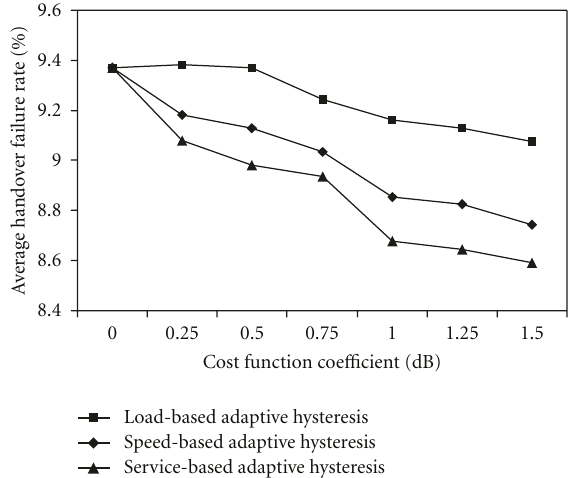
Figure 4: AHFR by the proposed cost-based adaptive hysteresis scheme under a variety of the cost function coe ffi cient ( α ) when call arrival rate is fixed at 0.03.